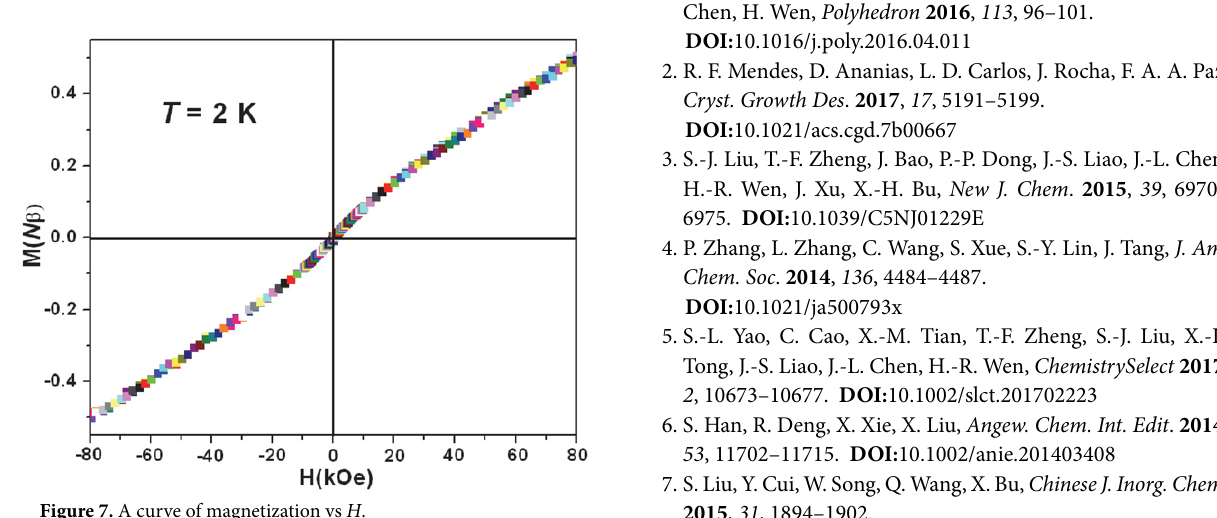
Figure 7. A curve of magnetization vs H